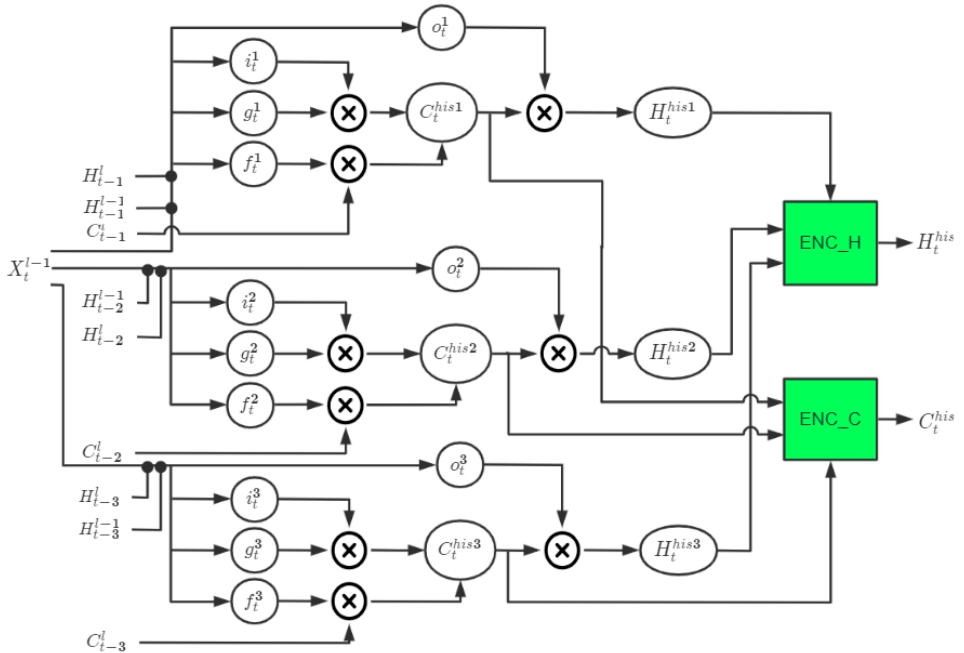
Figure 6. Proposed LSTM-Atten module.